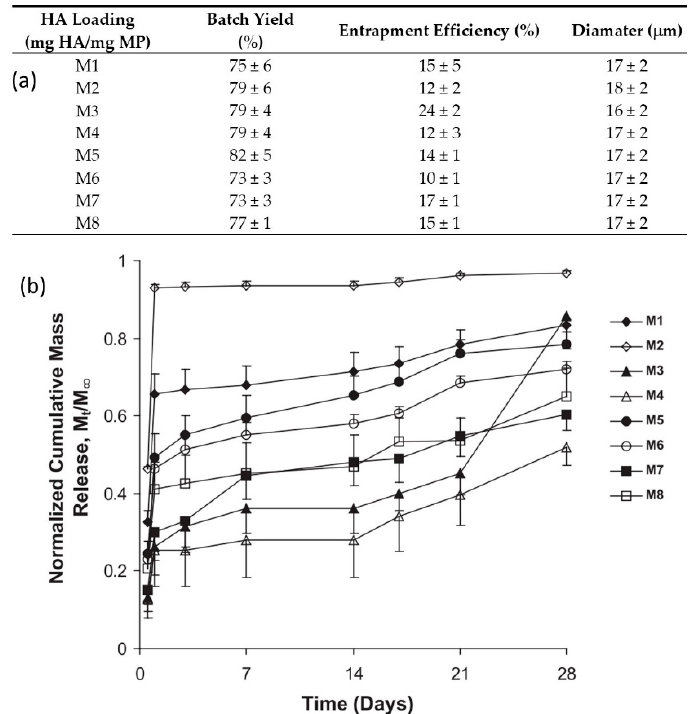
Figure 5. ( a ) Summary of microparticle (MP) properties. In their notation, HY stands for hyaluronic acid (HA). ( b ) Cumulative release of HA (or HY in their notation) from PLGA/PEG microparticles in PBS at 37.8 °C. The release is expressed as normalized mass release. The results are presented as means with ± standard deviation for five measurements. M1, M3, M5 and M7 micro-particles were produced by the higher molecular weight HA (see above text). From [49].